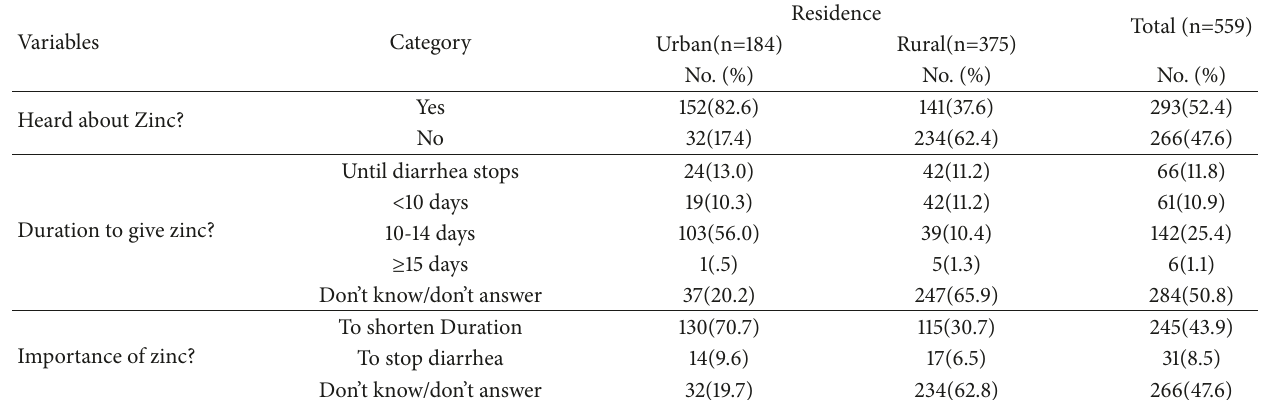
Table 4: Zinc supplementation for home management of diarrhea among caregivers of under-five children’s in urban and rural resident of Doba woreda,